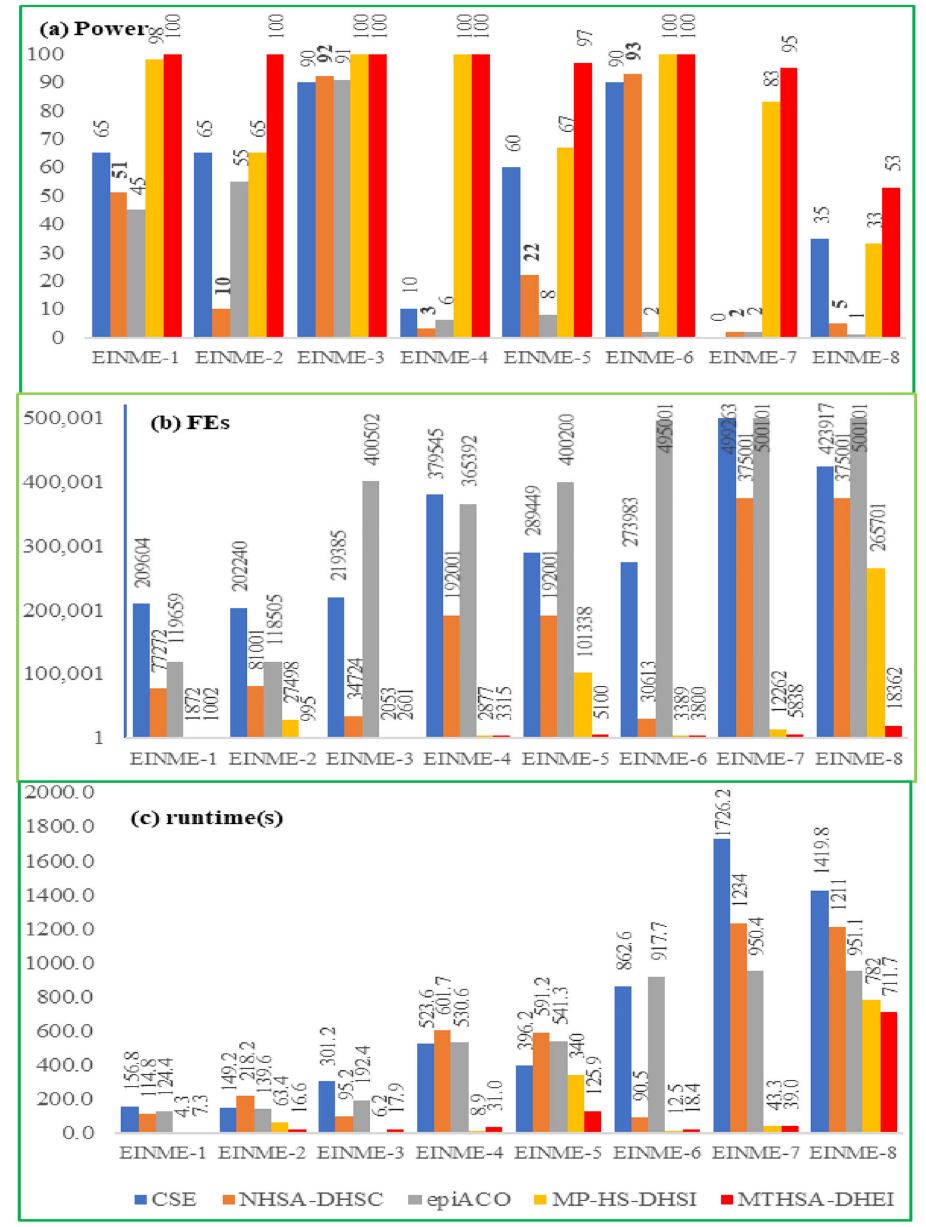
Fig. 8 Power, FEs and runtime of the five algorithms for detecting 8 EINMEs with 100